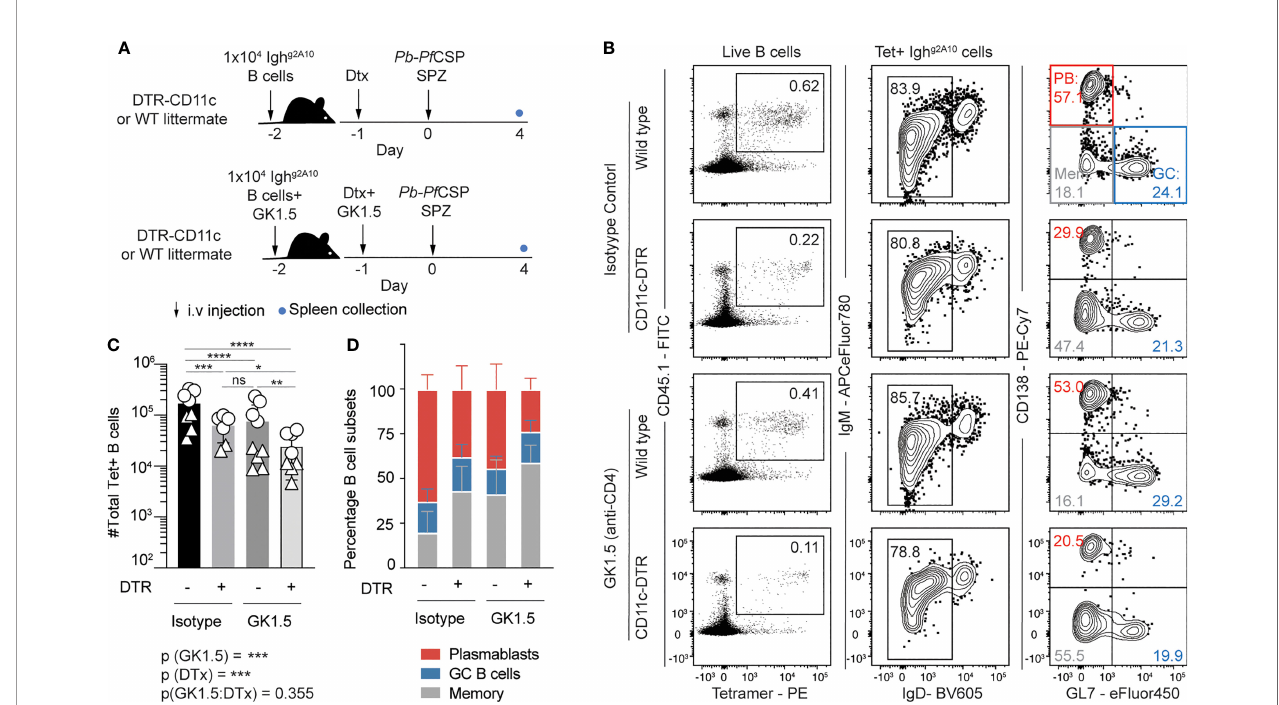
FIGURE 6 | Depletion of CD11c+ dendritic cells impairs plasmablast differentiation after sporozoite immunization. Mice received treatment with Diptheria toxin (Dtx) prior to transfer of 1x10 4 Igh g2A10 B cells and immunization with 5x10 4 Pb-Pf CSP SPZ. Selected mice were also depleted of CD4+ T cells with GK1.5 treatment at days -2 and -1, immune responses were assessed 4 days post-immunization. (A) Schematic of experimental protocol. (B) Representative fl ow cytometry plots showing the gating of Igh g2A10 B cells in each condition. Plots are pre-gated upon singlets, Dump-negative and B cells [CD19 + ± CD138 + ]. (C) Quanti fi cation of Pf CSP-speci fi c B cells from spleens of mice four days after immunization and phenotype (D) of Igh g2A10 B cells as a percentage of total Igh g2A10 cell number. Means ± s.d shown. Data pooled from two independent experiments, with 4-5 mice per group. Different icon shapes distinguish different experiments. Analysis performed by a linear mixed model, with different experiments set as a blocking factor to account for random effects between experiments. For (C) the overall interaction between fi xed effects is noted with the p-value underneath the main fi gure, while the pairwise values derived from post tests are indicated on the graph itself. Abbreviations for p values are: ns, not signi fi cant; p < 0.05 = *; p < 0.01 = **; p < 0.001 = ***; p < 0.0001 =